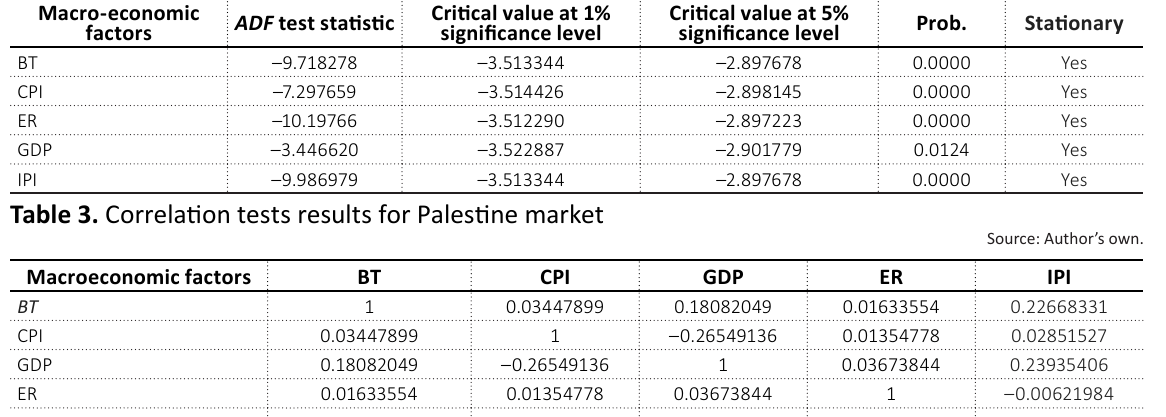
Table 2. Unit root tests results for Palestine market